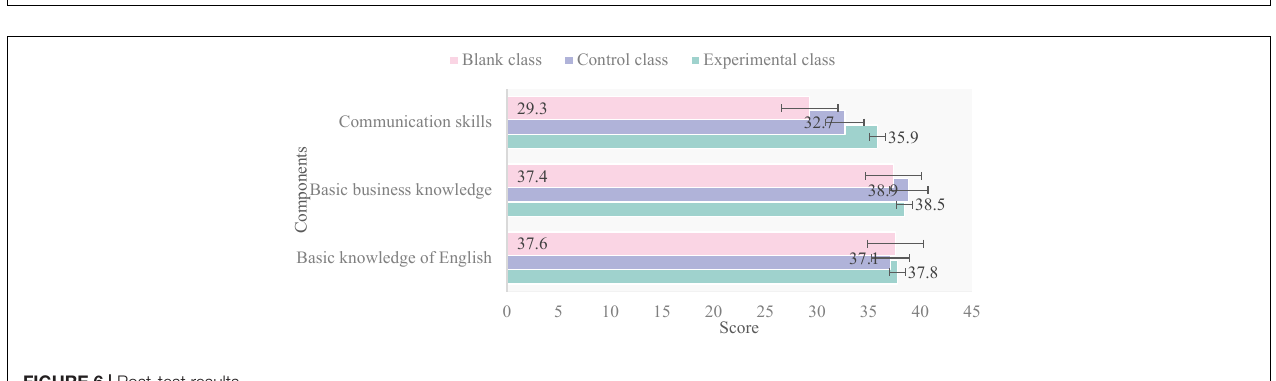
FIGURE 5 | The results of intermediate test.